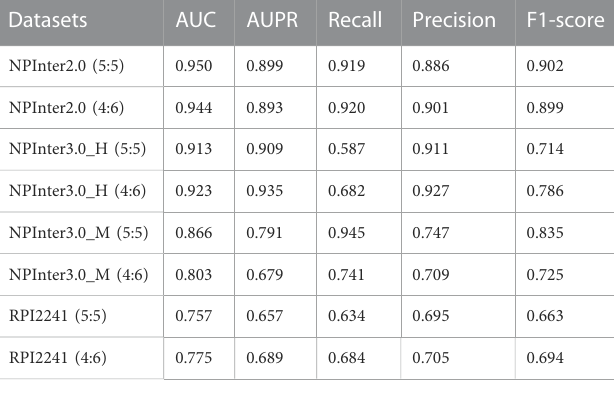
FIGURE 6 Model loss curve.